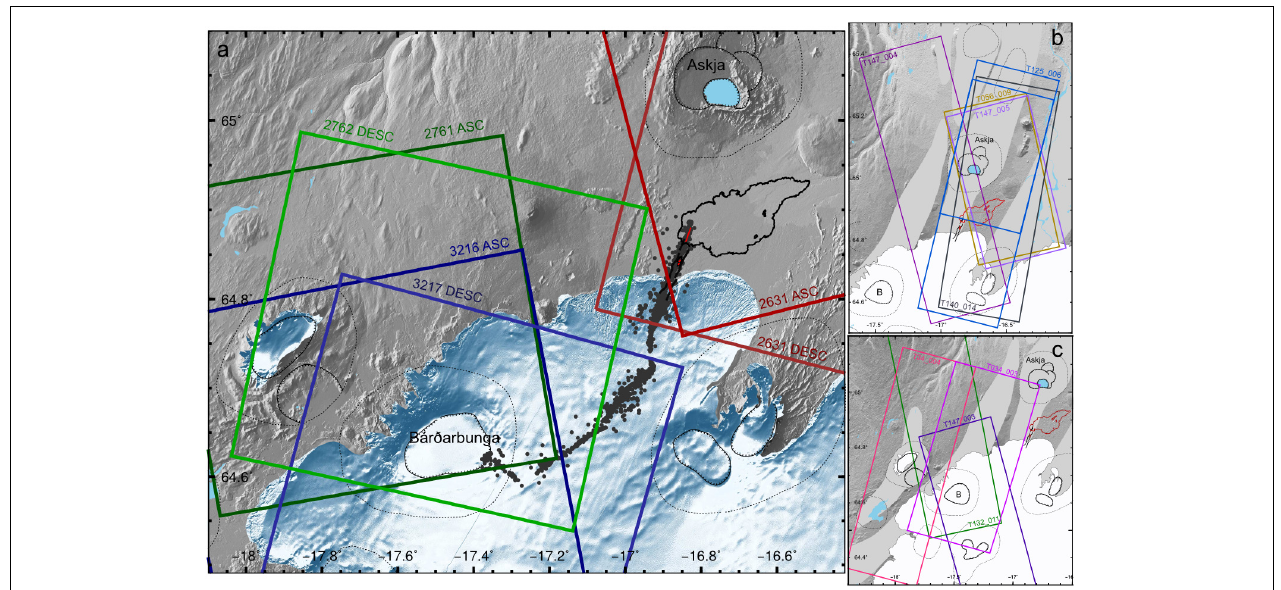
FIGURE 2 | Tracks of SAR satellite images acquired during the unrest at Bár ð arbunga and during the 2014–2015 Holuhraun eruption. Footprints of Cosmo-SkyMed satellite images (a) , and most frequent TerraSAR-X images acquired over Holuhraun and Bár ð arbunga (b,c) , respectively (see Figure 3 ). Dark gray dots in (a) represent seismic events related to the dyke propagation after Sigmundsson et al. (2015). B for Bár ð arbunga